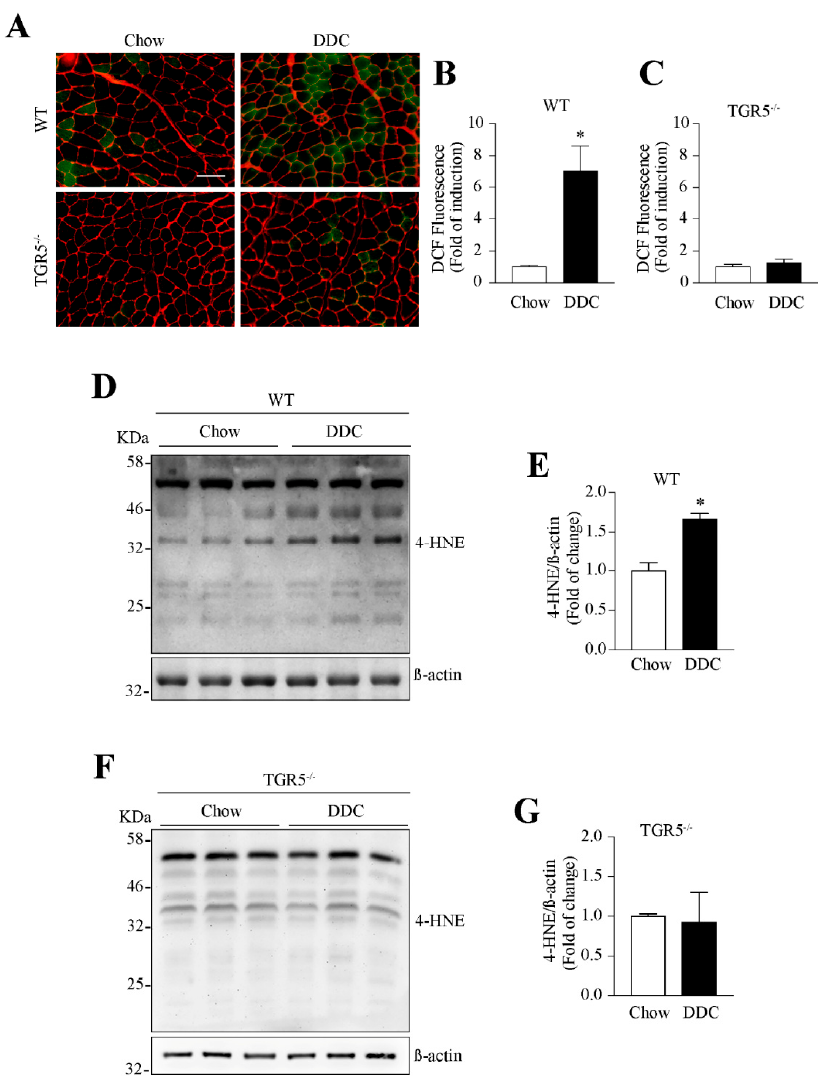
Figure 8. The muscular oxidative stress in mice with DDC-induced CLD is dependent on TGR5 expression. C57BL / 6J male WT and TGR5 − / − mice were fed with a chow or DDC-supplemented